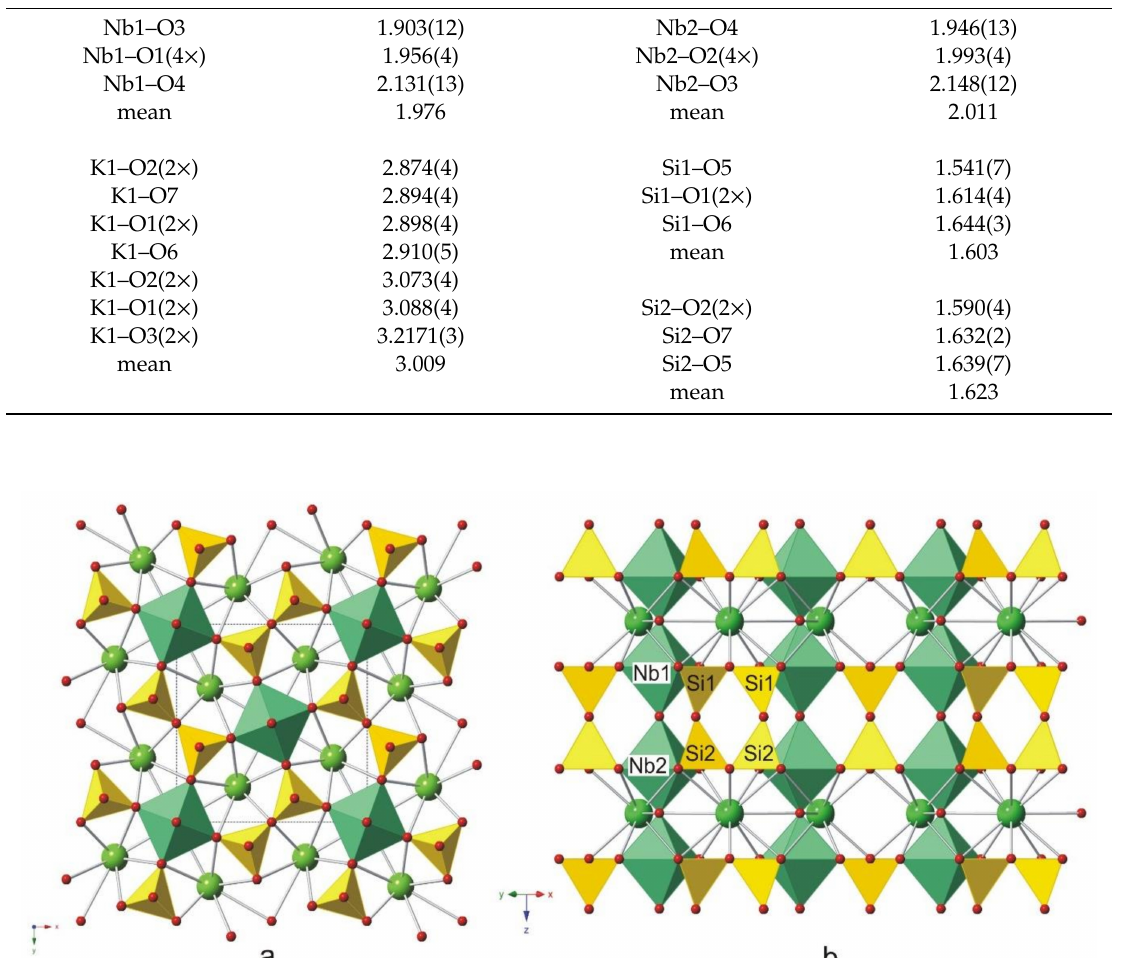
Table 9. Bond lengths (Å) for rippite.